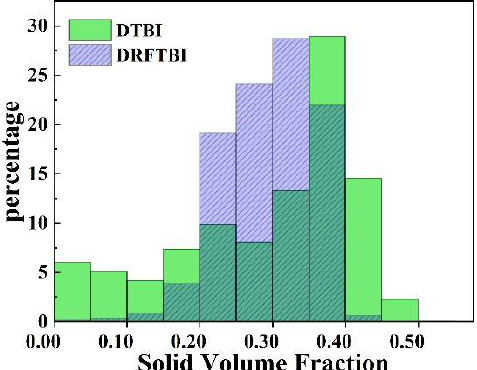
Figure 7. Histogram of solid distribution for different impeller types. (Rotational speed: 120 rpm; solid loading: 30%; connection strap length: 1.2 H S .)